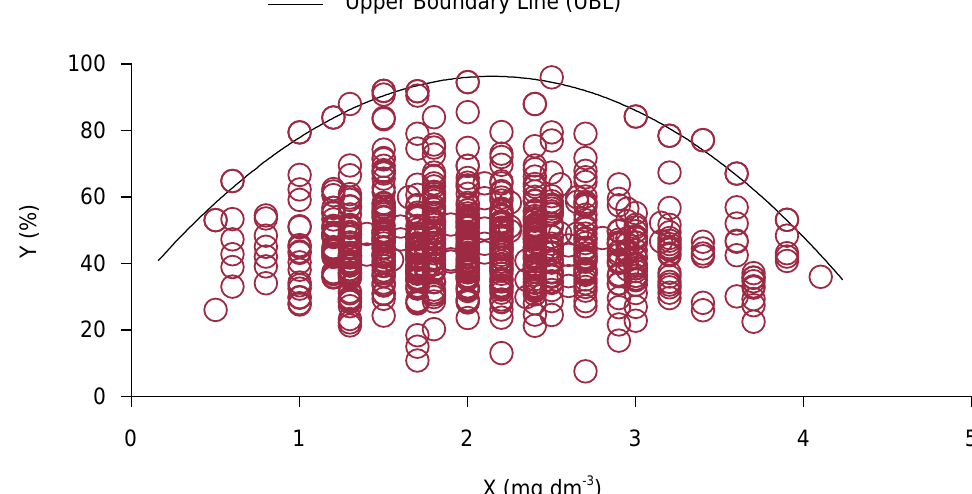
Figure 2. Example of the Upper Boundary Line of the relationship between two variables (relative yield and nutrient content in the